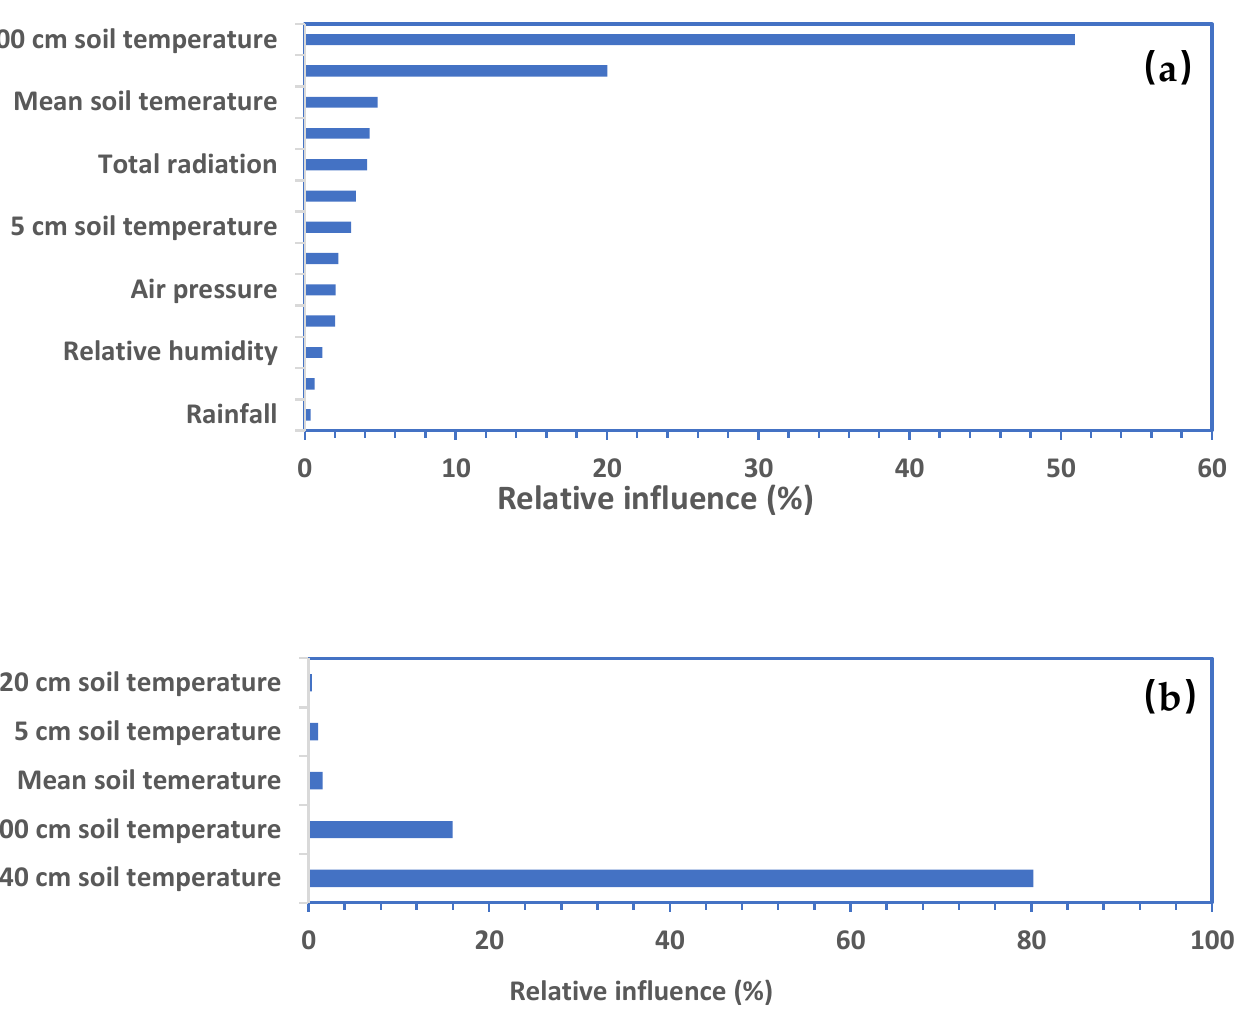
Figure 5. Relative influence of environmental factors on soil water storage during the growing season ( a ) and the non-growing season ( b ).